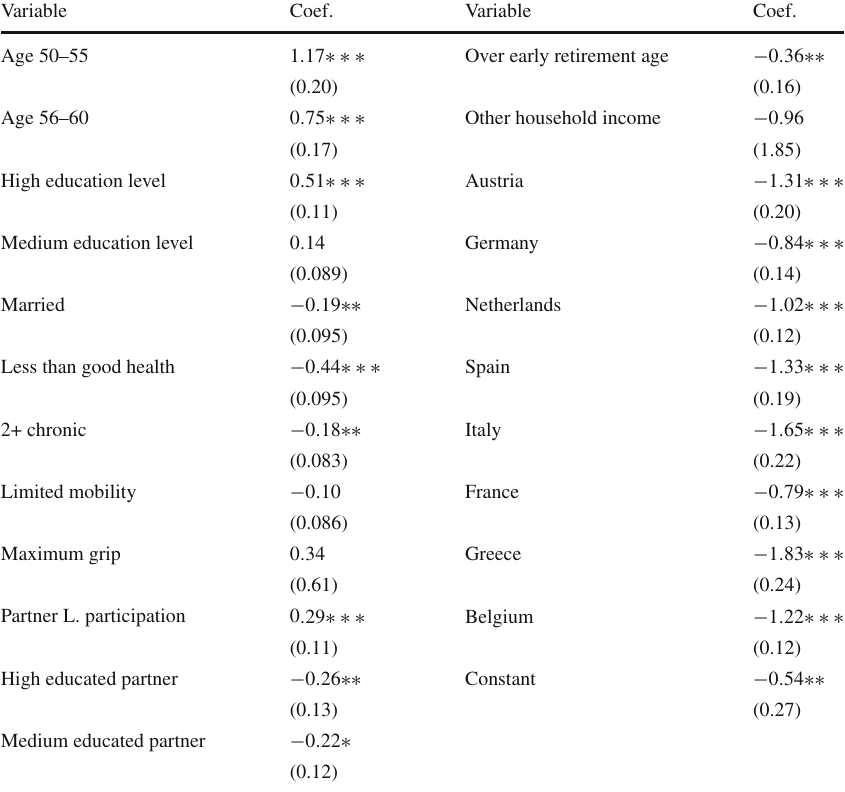
Table 10 Maximum likelihood estimates. Labor participation decision of the grandmother Variable Coef. Variable